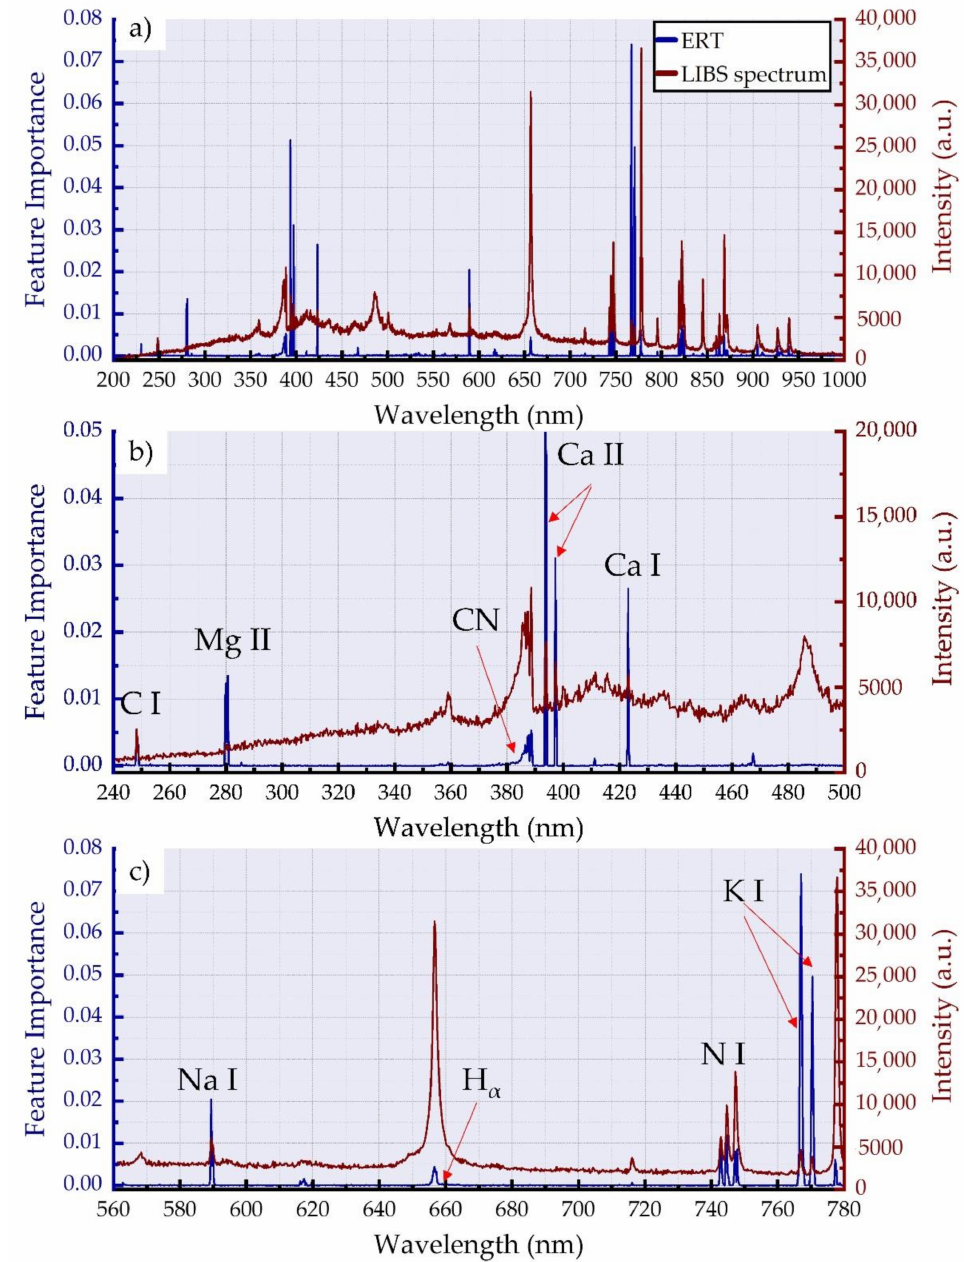
Figure 5. Feature importance plot obtained using the ERT algorithm together with a honey LIBS spectrum in the ( a ) 200–1000 nm, ( b ) 240–500 nm, and ( c ) the 560–780 nm spectral